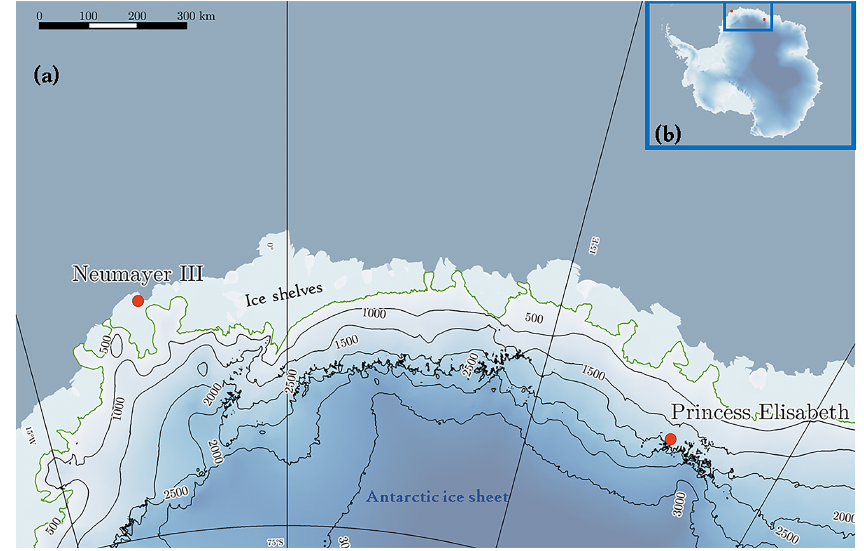
Figure 2. (a) Topographic map of the location of Neumayer and Princess Elisabeth stations in Dronning Maud Land. The color intensity rep- resents the Fretwell et al. (2013) surface elevation. We use 500m surface elevation contours from Bamber et al. (2009) and the grounding line from Bindschadler et al. (2011) (green). (b) Map of the continent with the location of the two stations indicated in red. Source: